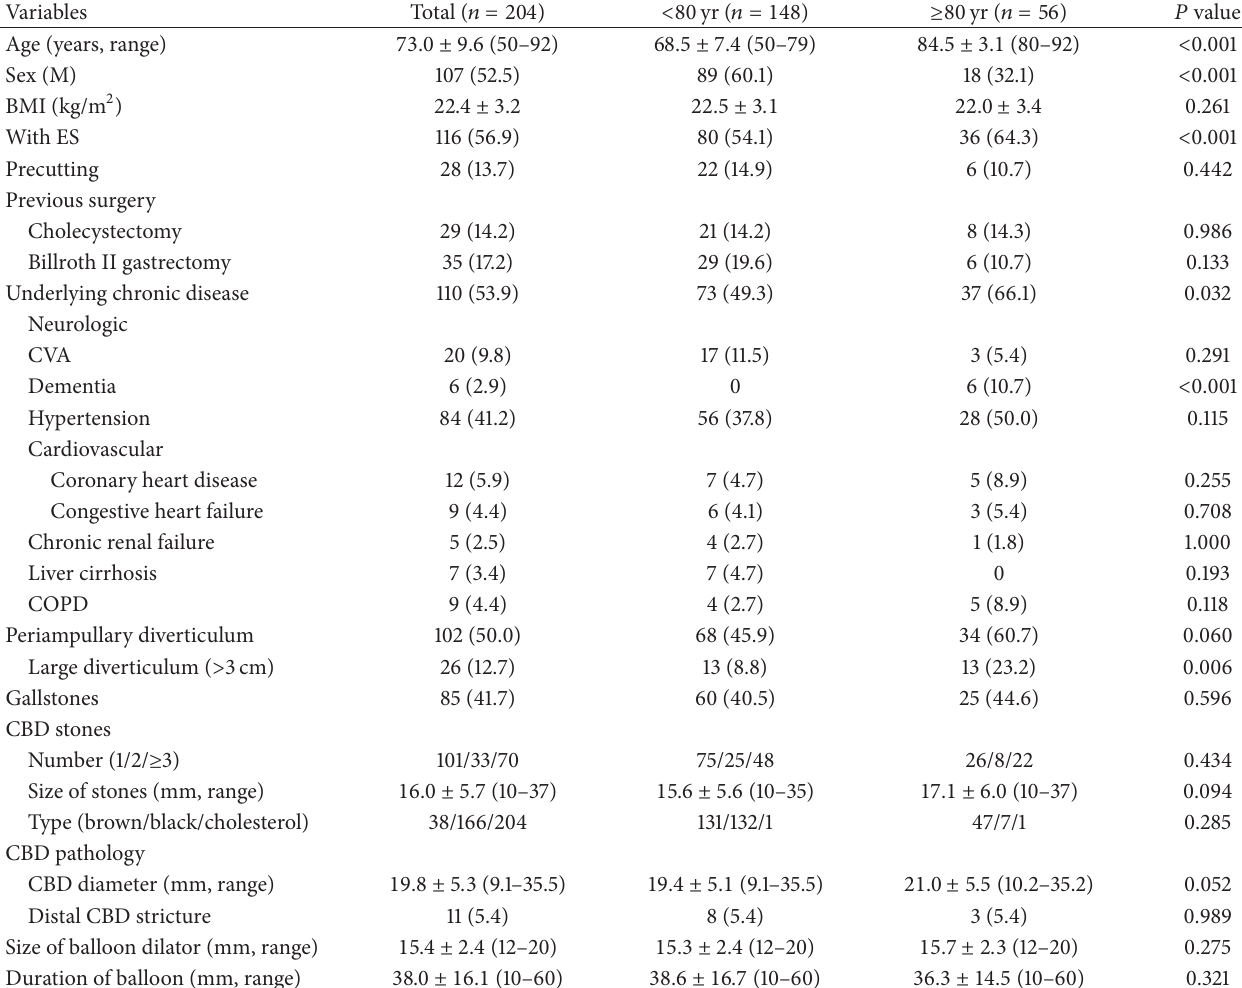
Table 1: Demographics and baseline characteristics.